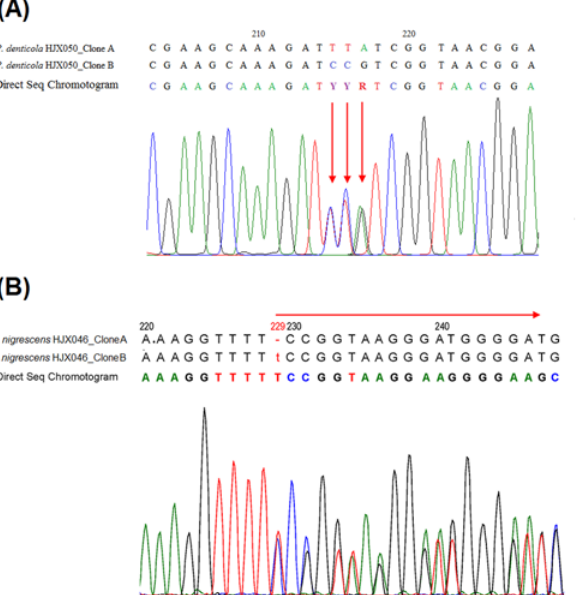
Fig 1. 16S rRNA sequence trace data for the isolates Prevotella denticola HJX050 and Prevotella nigrescens HJX046, showing comparison sequence data for heterogeneous clones and direct sequencing with single ambiguous bases (A) or continuous ambiguous bases (B). Prevotella nigrescens HJX046 clone A had a deletion at nucleotide position